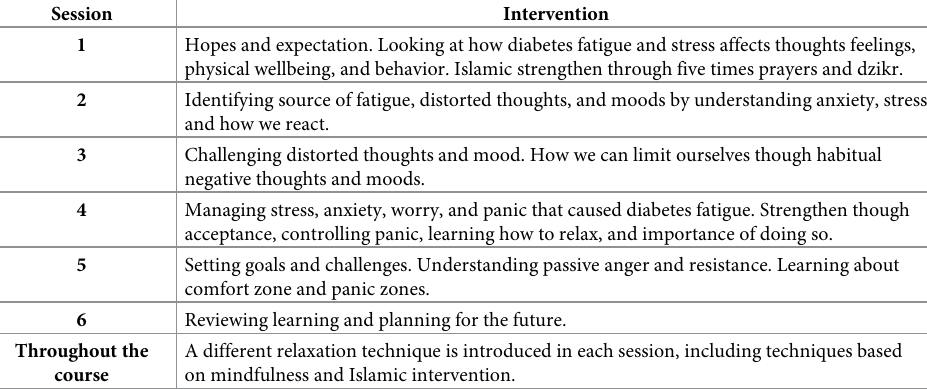
Table 1. Overview of the resilience based Islamic